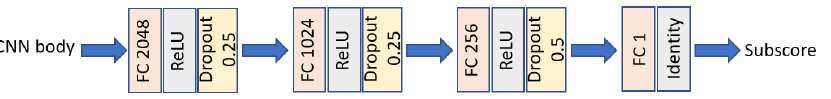
Figure 6. Structure of the regression head. The first three layers contains 2048, 1024 and 256 nodes with dropout rates of 0.25, 0.25 and 0.5, respectively. Since the last layer predicts perceptual quality, it contains one